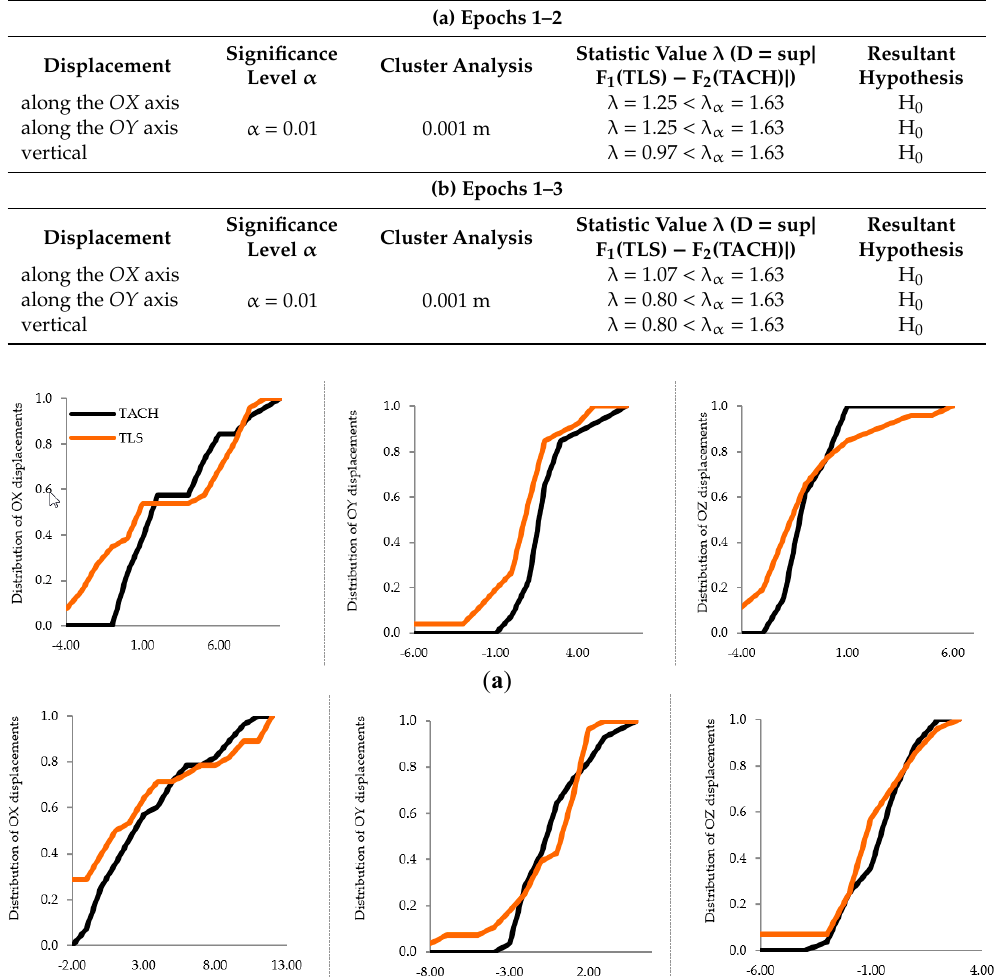
Table 8. Two-sample Kolmogorov–Smirnov (K-S) test results; TLS vs. TACH (tacheometry), case